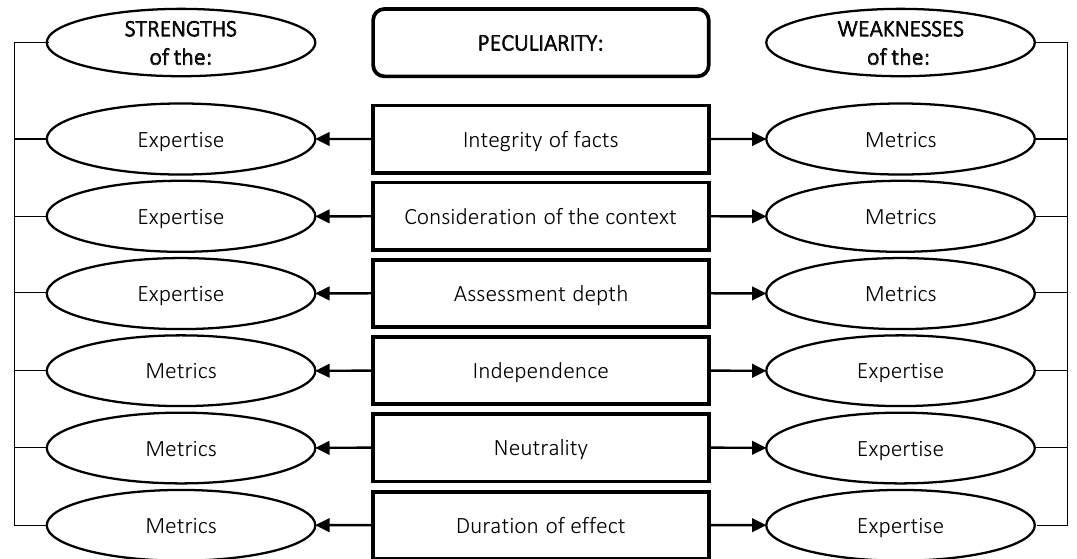
Figure 1. Strengths and weaknesses of metrics and expertise procedures in the process of assessing